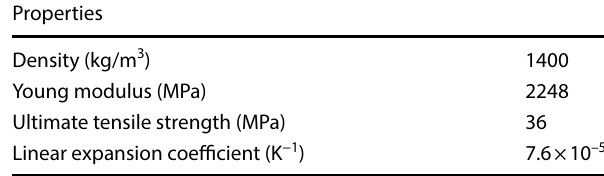
Table 4 Plastic pipes